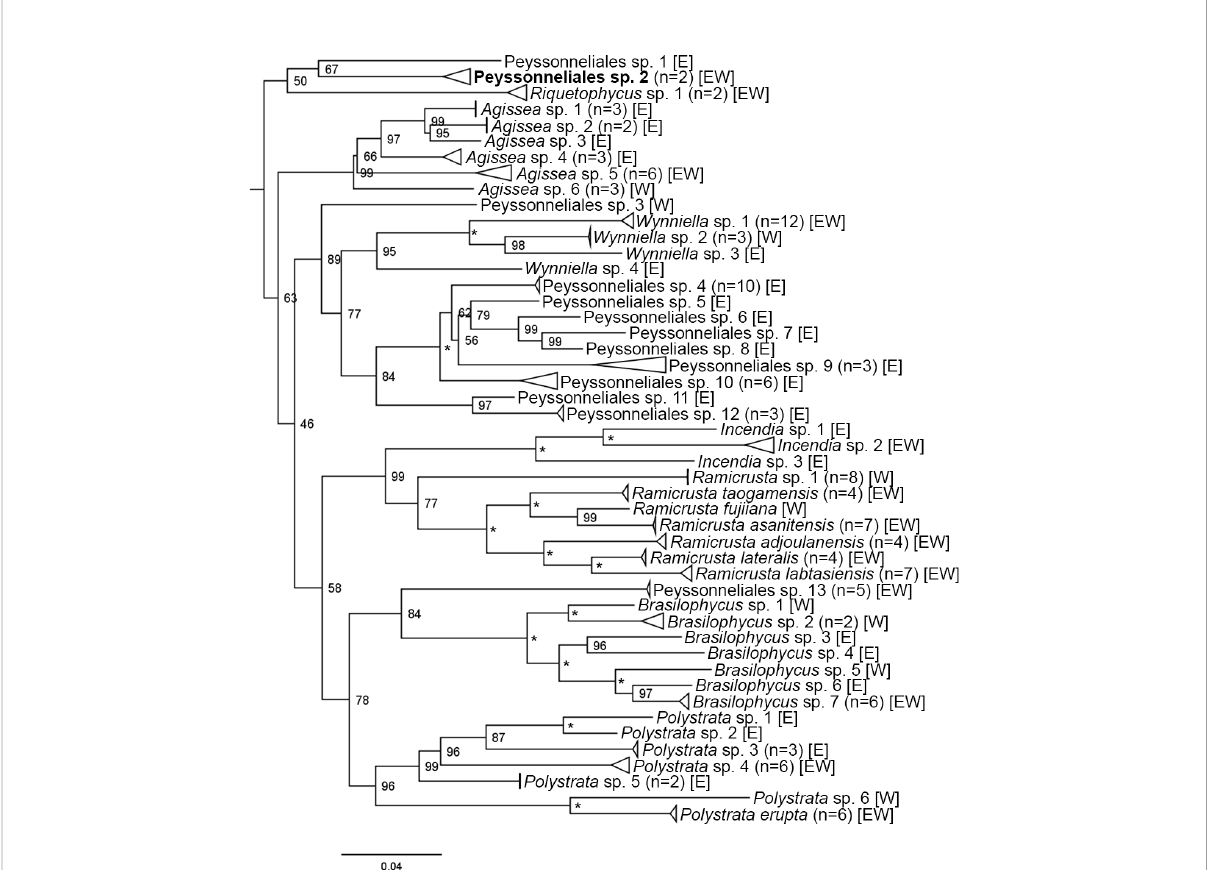
FIGURE 3 Maximum likelihood phylogenetic tree of concatenated COI-5P and psb A sequences for all specimens collected during this study belonging to the order Peyssonneliales with bootstrap support values located at the nodes. Asterisks (*) denote nodes with full support. The side of the island that each species was found is shown using [E] for east side, [W] for west side, and [EW] for both sides. Tips denote putative species (n=48). Species recognized by ABGD, but split into one or two additional sister species by bPTP species delimitation are in bold type. Plocamium cartilagineum (Linnaeus) P.S.Dixon was used as the outgroup and pruned from the depicted